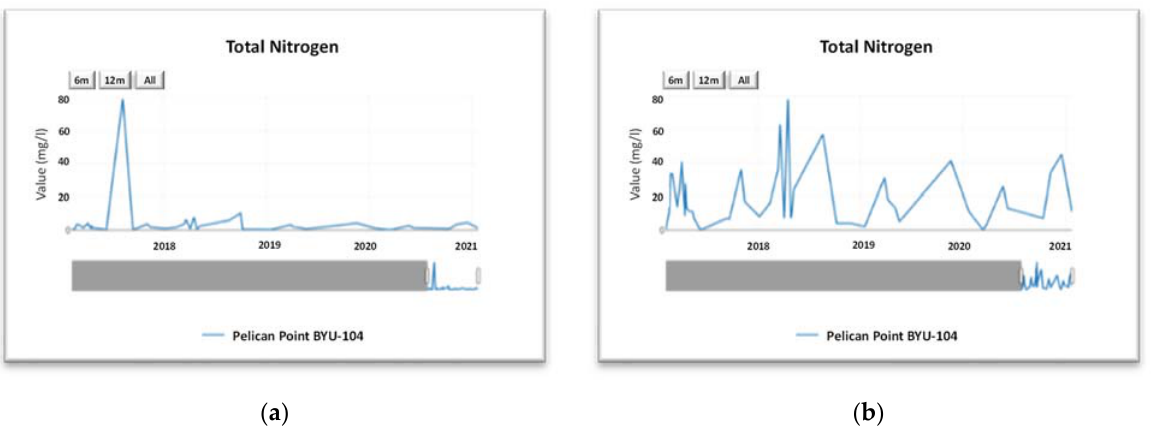
Figure 5. Timeseries for Total Nitrogen at BYU ‐ 104 station. ( a ) All data; ( b ) <1 Standard Deviation.